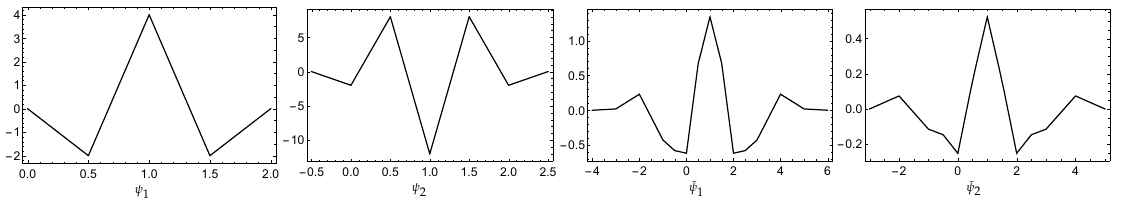
Figure 4. The graphs of the framelets and its dual framelets of Example